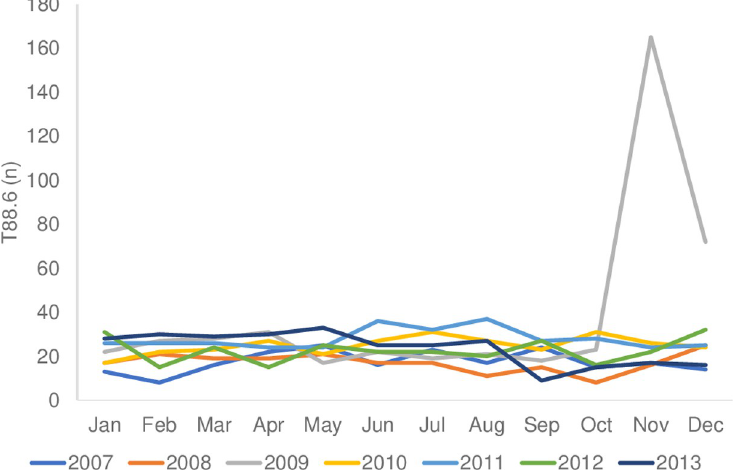
Fig 6. Monthly distribution of T88.6 through 2007–2013 ( P < 0.001). T88.6, anaphylactic shock due to the adverse effect of an appropriate drug or medication properly administered.